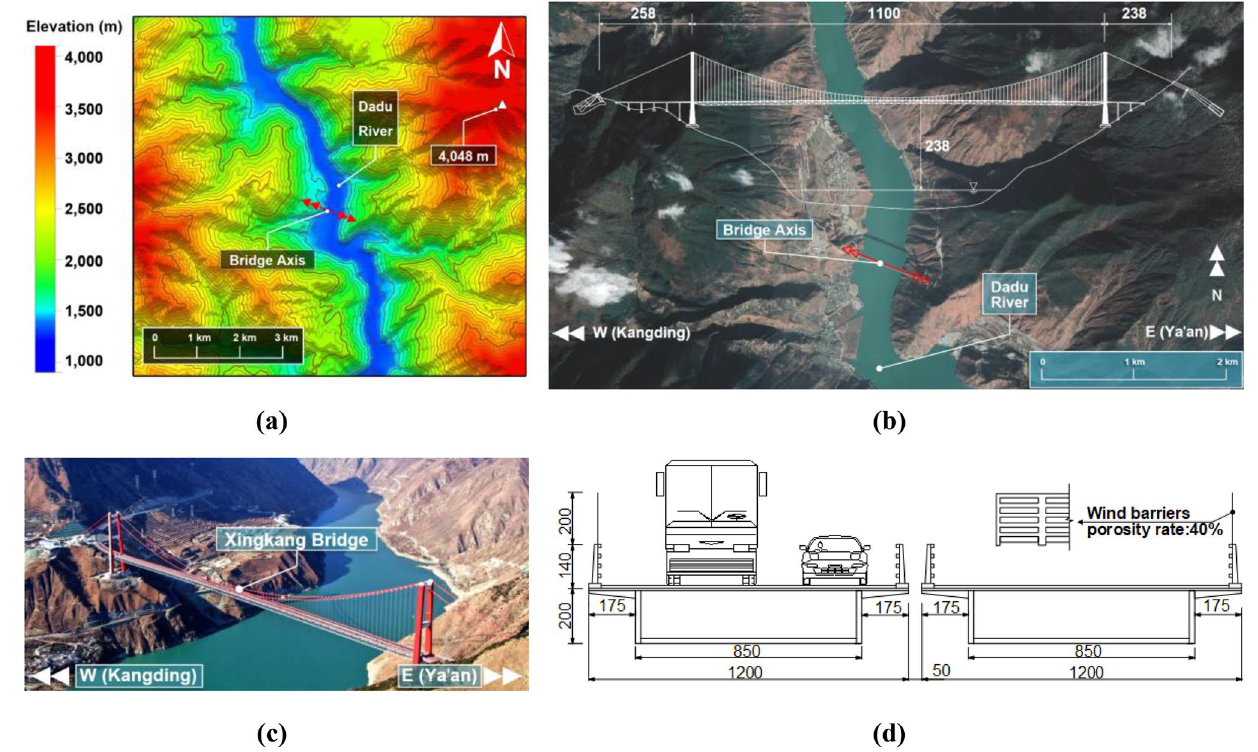
Figure 1. Topography and surroundings around the bridge site: ( a ) topographic contour map, ( b ) geomorphology map and overall layout of the Xingkang bridge (unit: m), ( c ) aerial view of Xingkang bridge, ( d ) cross section of approach bridge (unit: